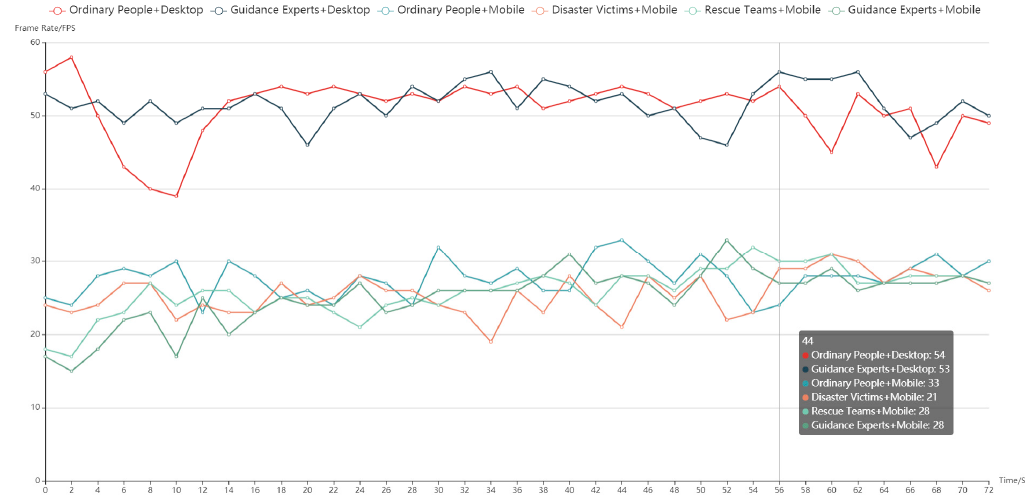
Figure 11. Real-time rendering frame rate of the experimental process for various users